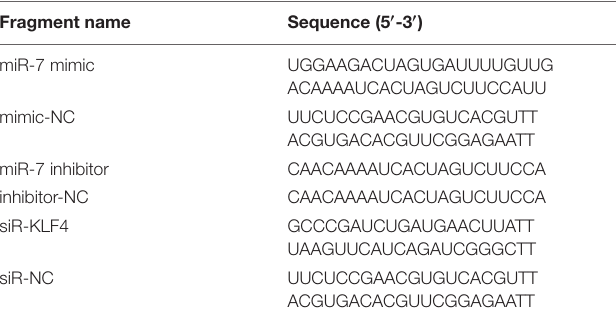
TABLE 3 | Oligonucleotide sequences for overexpression and inhibition. Fragment name Sequence (5 (cid:48) -3 (cid:48)